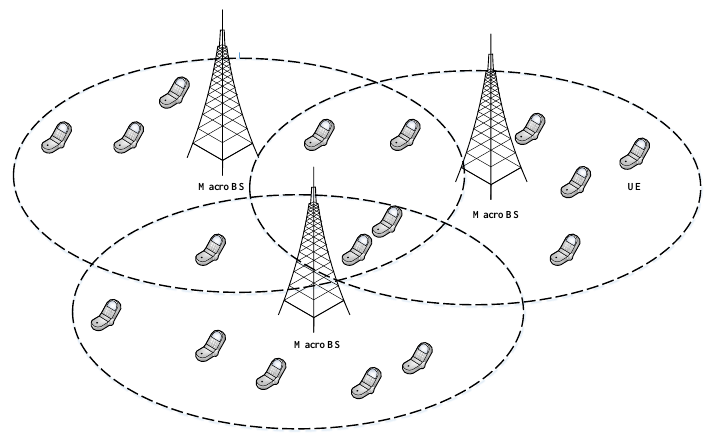
Figure 2. User equipments (UEs) placed in a homogeneous environment. Some UEs can access two or more macro base stations